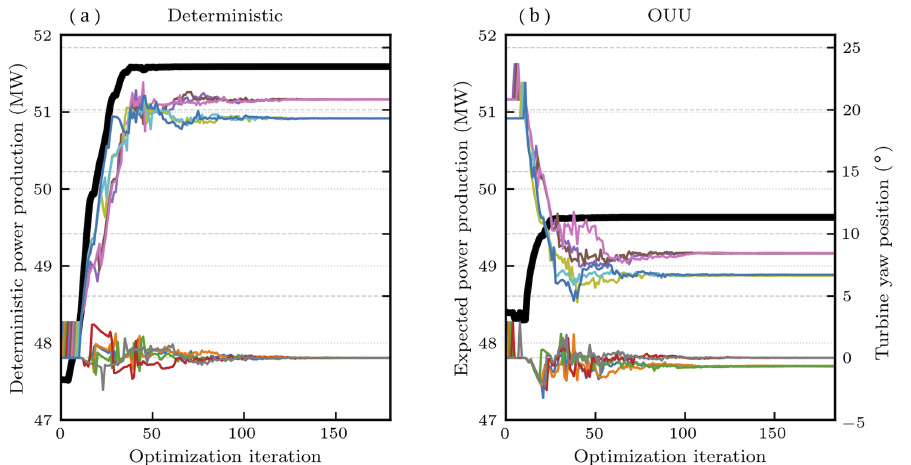
Figure 10. Optimization histories for deterministic (a) and stochastic (b) 11-turbine wind plant optimization studies with 12ms − 1 inflow 30 ◦ from north. The deterministic optimization was initialized with the baseline strategy, and the stochastic optimization was initialized with the deterministic solution. The thick black line in each panel shows power (left vertical axes), and the thin multicolored lines show the yaw positions of the different turbines (right vertical axes).